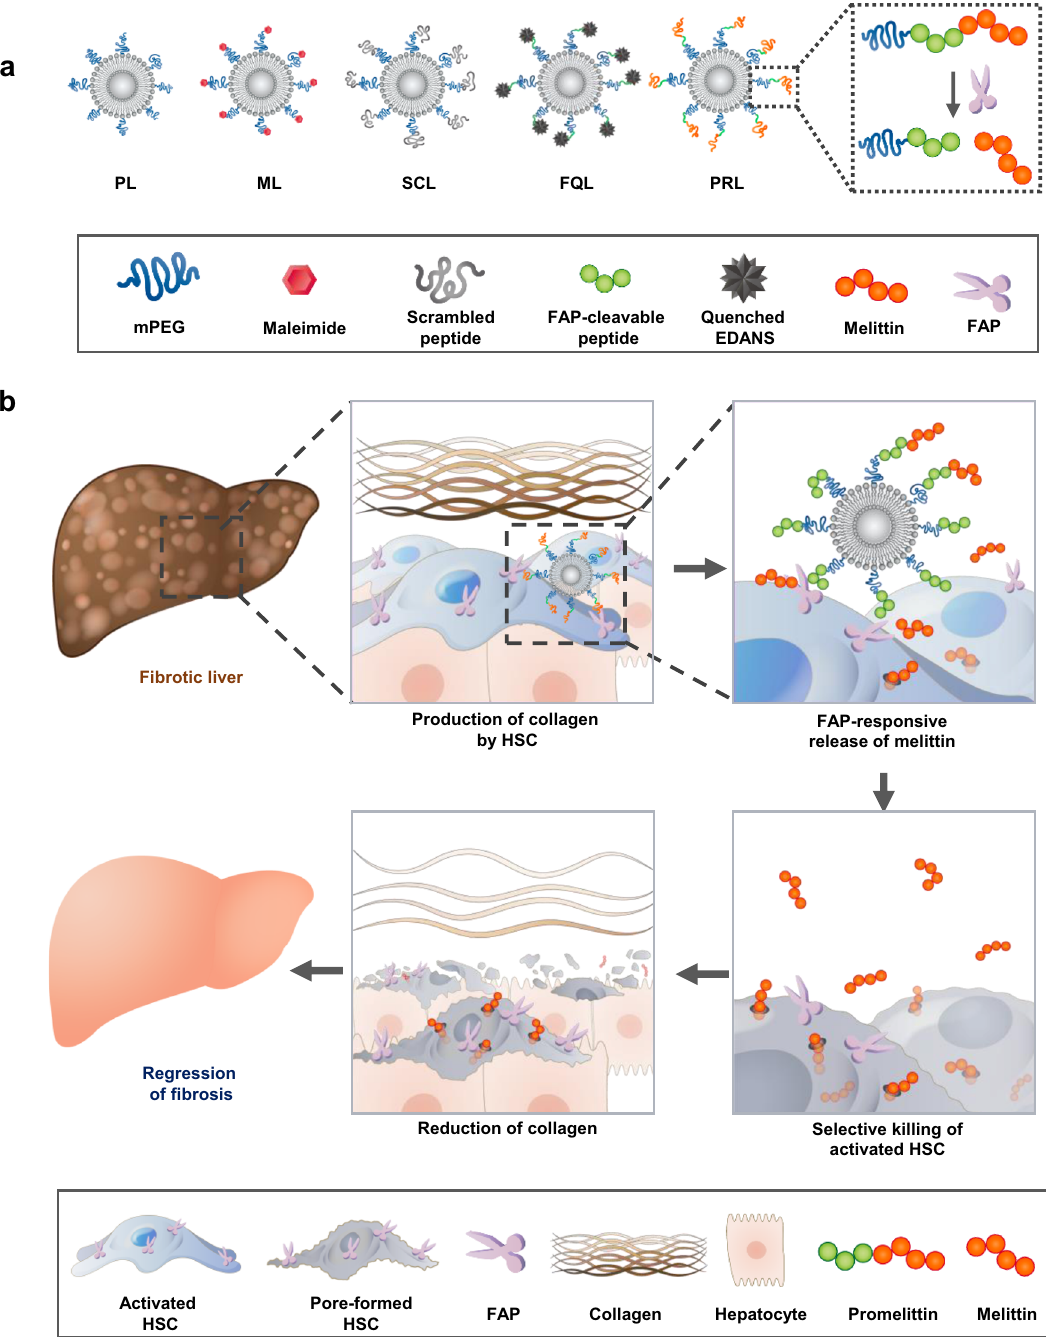
Fig. 1 Proposed working mechanism of PRL against liver fi brosis. a Schematic illustration of various liposome formulations. FAP-responsive PRL were synthesized by linking cys-promelittin onto the surface of ML. b In a fi brotic microenvironment, the promelittin moiety on PRL is cleaved by FAP on aHSC. FAP-mediated cleavage of promelittin on PRL releases melittin, which diffuses to nearby aHSC, creating pores in their cell membranes. The resulting reduction in the number of aHSC in fi brotic tissues leads to decreased production of collagens and regression of fi brosis. PL plain PEGylated liposomes; ML maleimide-activated PEGylated liposomes; SCL scrambled cys-promelittin peptide-tagged liposomes; FQL promelittin-mimicking fl uorescence-quenched peptide-tagged liposomes; PRL promelittin-modi fi ed liposomes; FAP fi broblast activation protein; EDANS, 5-[(2-aminoethyl) amino]naphthalene-1-sulfonic acid; HSC hepatic stellate reducing it to less than 40% (Fig. 3f). Fluorescence live/dead cell (Fig. 3g) and siFAP-treated LX-2 cells (Fig. 3h) retained full viability follow treatment with liposomes, regardless of liposome type, whereas only treatment of LX-2 cells with PRL resulted in an increase in the dead cell population (Fig. 3i).